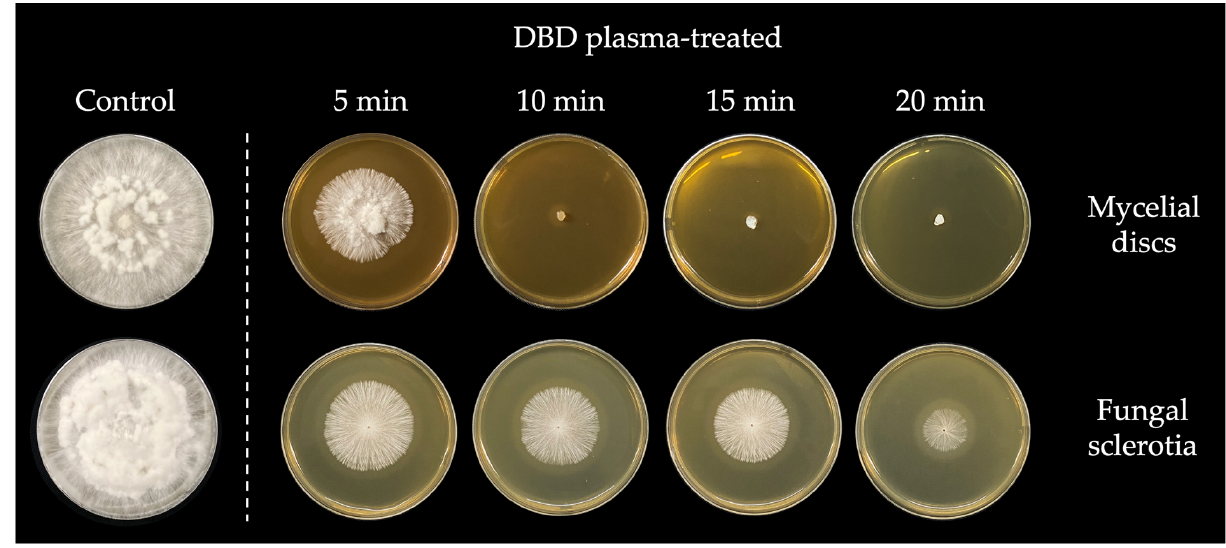
Figure 2. In vitro inhibition of Athelia rolfsii treated with the DBD plasma for different exposure durations. The results were photographed at 4 and 5 days after incubation for mycelial discs and sclerotia, respectively.